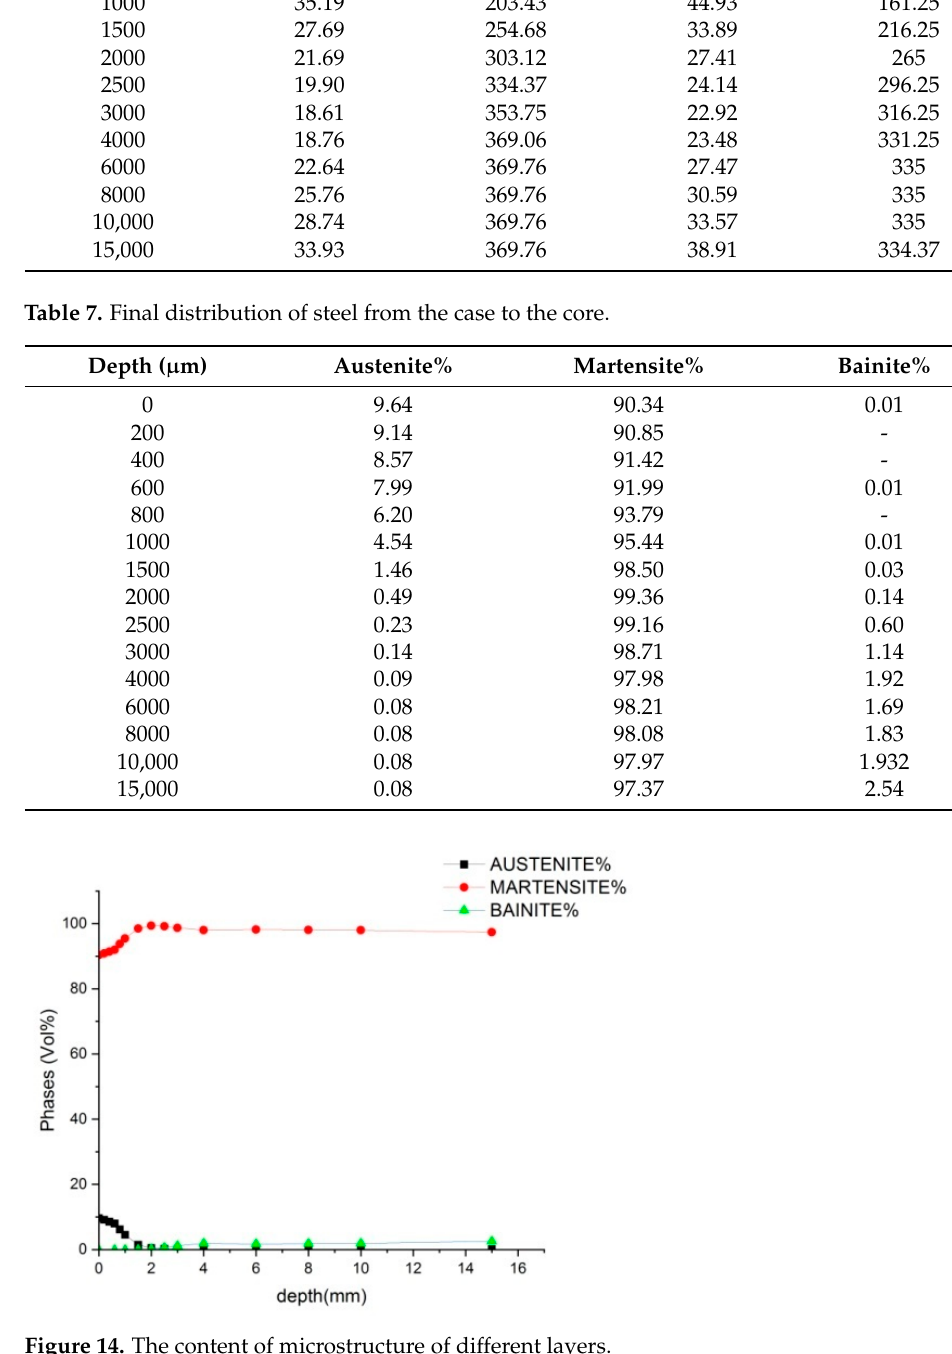
Figure 14. The content of microstructure of different layers.